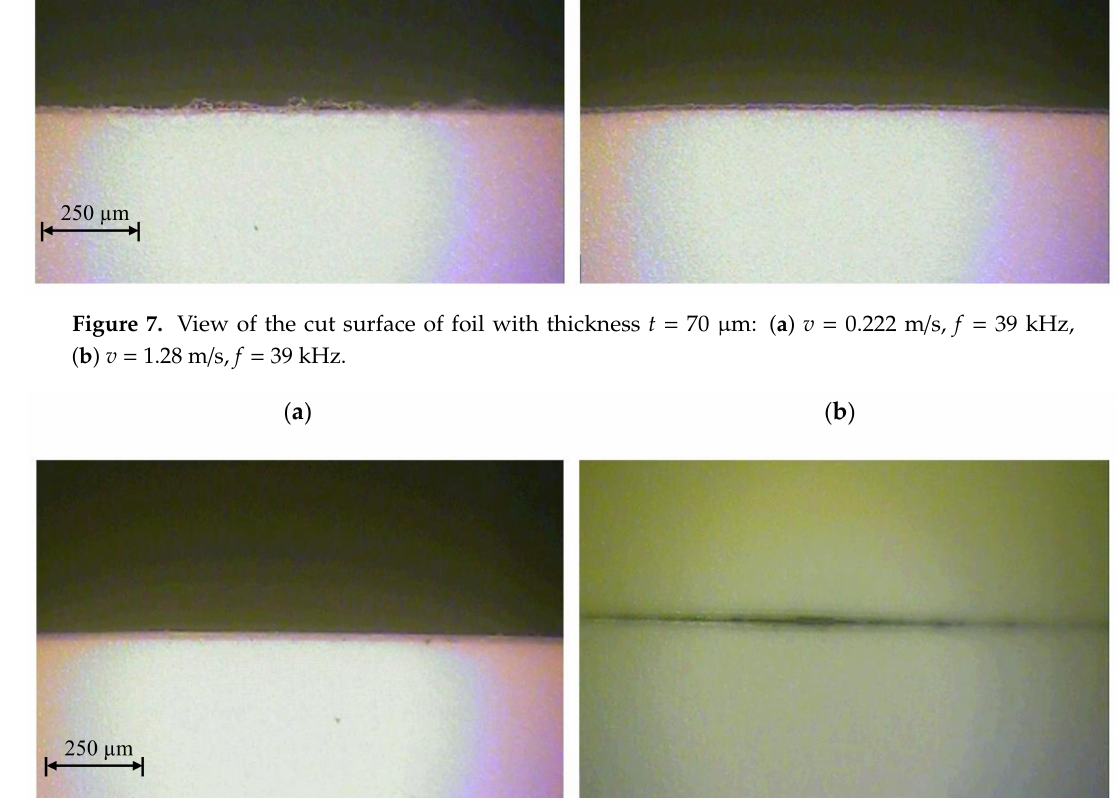
Figure 8. View of the cut surface of foil with thickness t = 80 µ m: ( a ) v = 1.5 m / s, f = 85 kHz, ( b ) v = 0.751 m / s, f = 150 kHz.